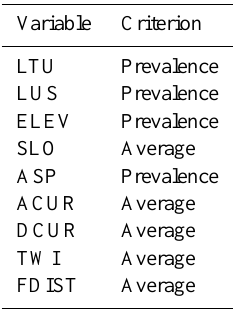
Lft = Landslide frequency threshold. Table 3. Criteria for assigning values of territorial variables to slope units. Fig. 6. Susceptibility maps obtained with square cells and dummy variables for tested sampling area: (A) All area; (B) Transects; (C) Buffer 1 / 1; (D) Buffer 1 /